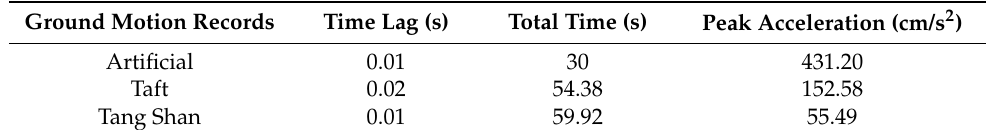
Table 10. T he parameters of ground motion records. Table 10. The parameters of ground motion records.